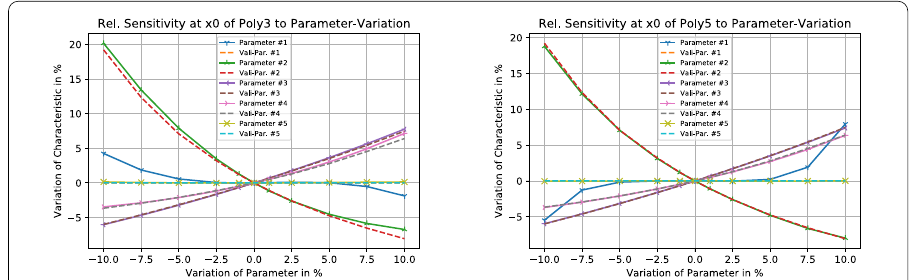
Fig. 27 Plate rel. sensitivity for third and fifth polynomial degree